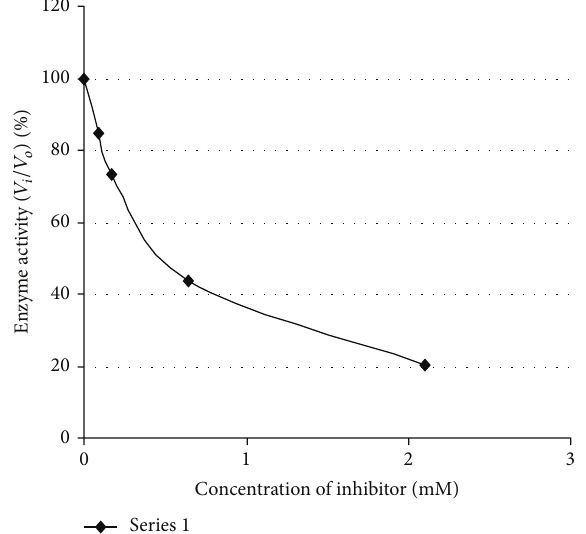
Figure6:IC50curveforPMSF(theeffectiveconcentrationofPMSF for reducing enzyme activity up to 50%).